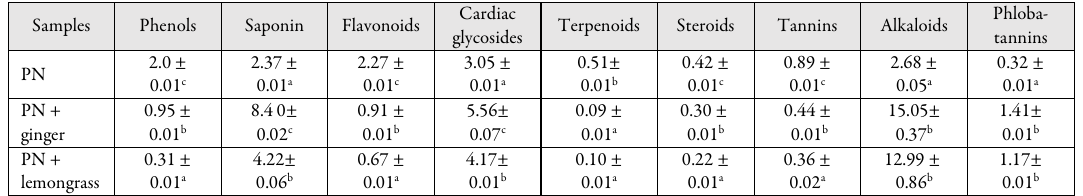
Table 2. Concentration of selected secondary metabolites of infused extracts of Parquetina nigrescens leaf